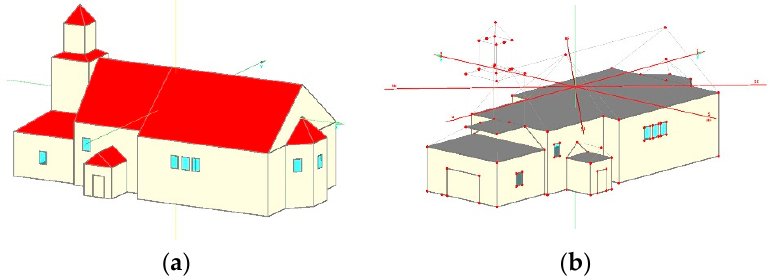
Figure 4. Geometric model of the studied object: ( a ) south-eastern elevation; ( b ) view from the southwest, including nodes and separation of the simulated